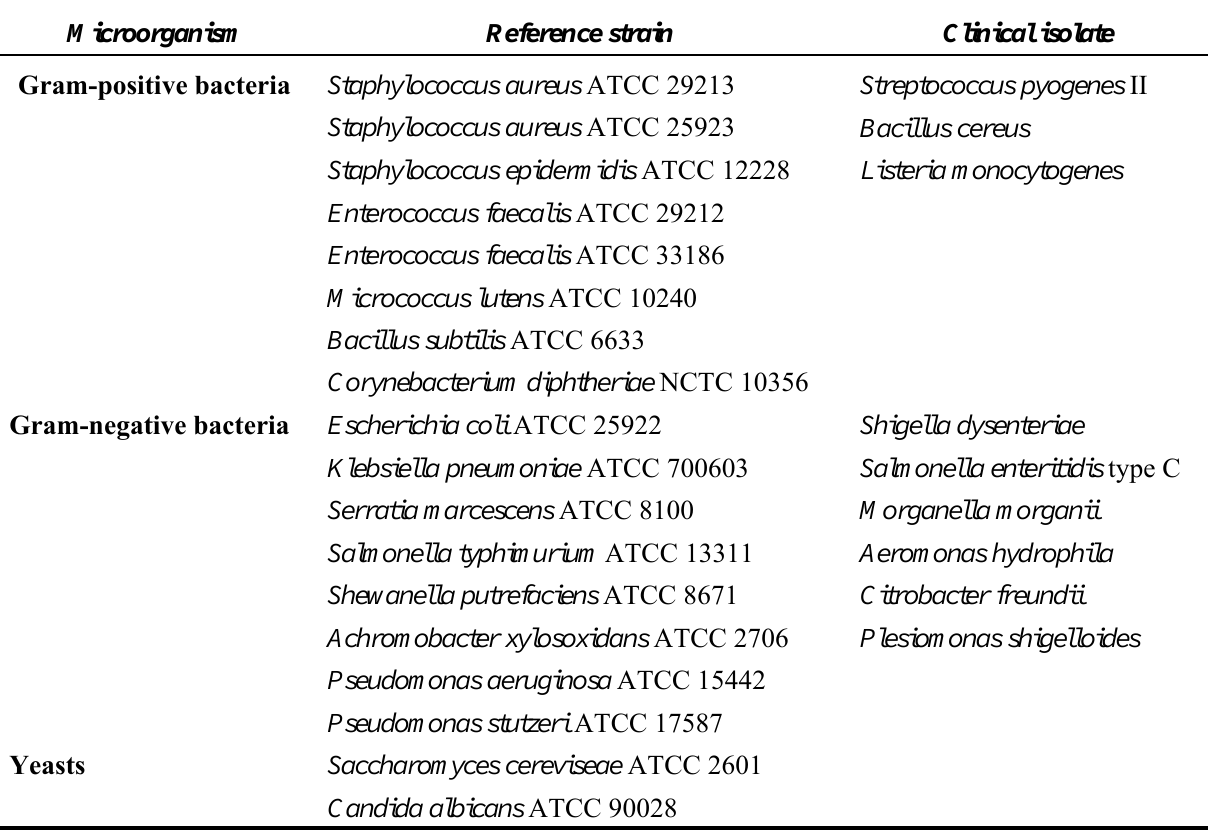
Table 8. Organisms subjected to growth inhibition